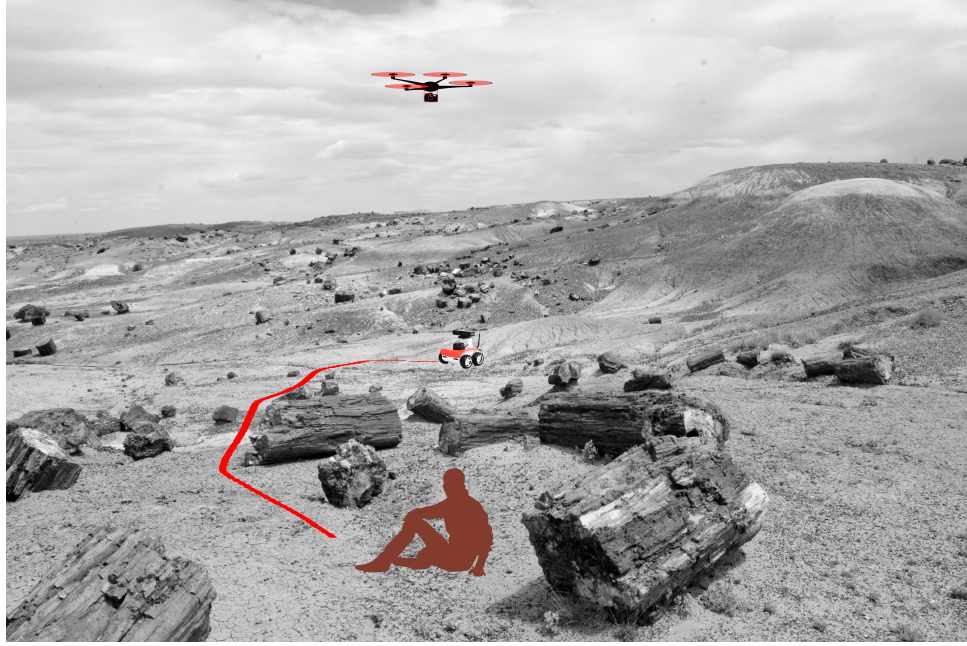
Figure 1. Conceptional illustration of a search and rescue mission utilizing a drone and